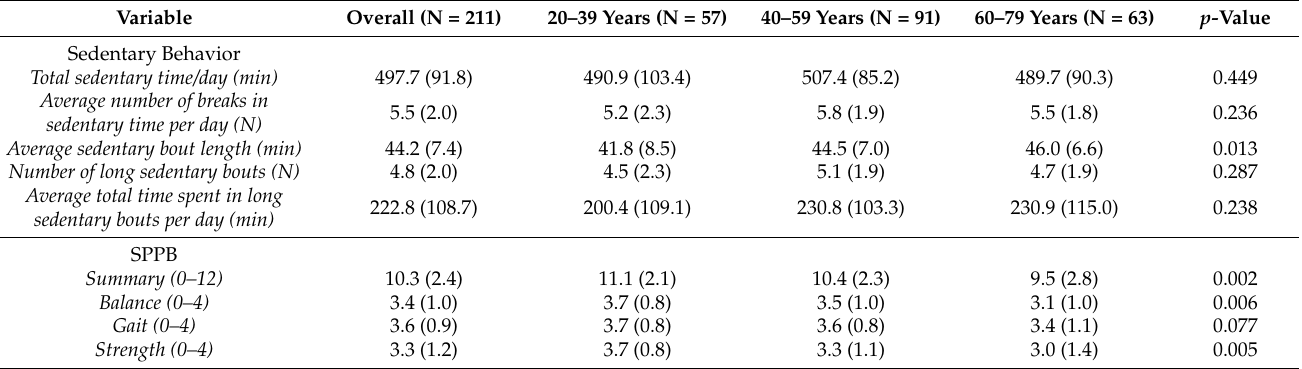
Table 2. Overall volume and pattern of sedentary behavior and scores for Short Physical Performance Battery (SPPB) for the overall sample and across age groups of persons with multiple